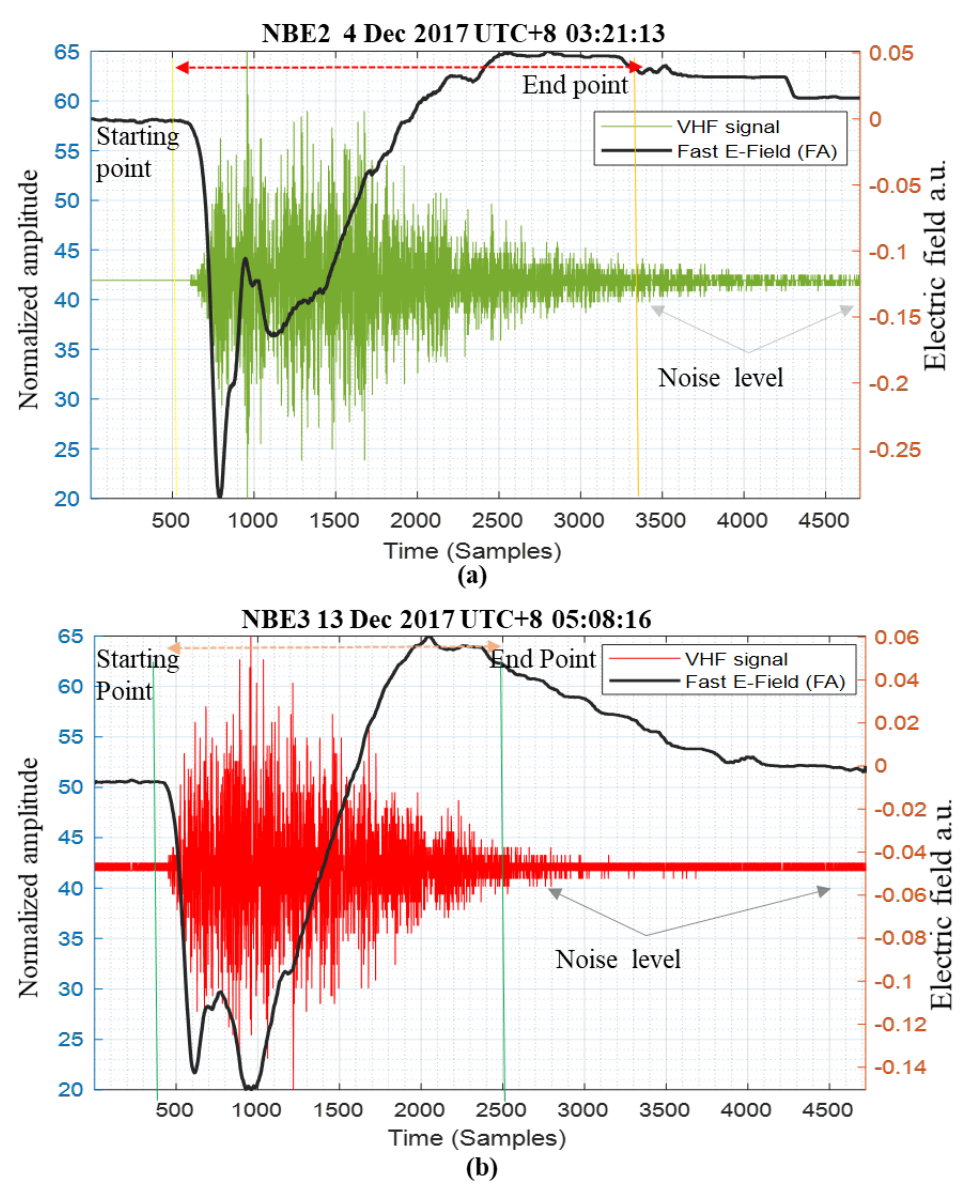
Figure 9. Interferometer data: ( a ) NBE2 and ( b ) NBE3 using lightning event extraction.